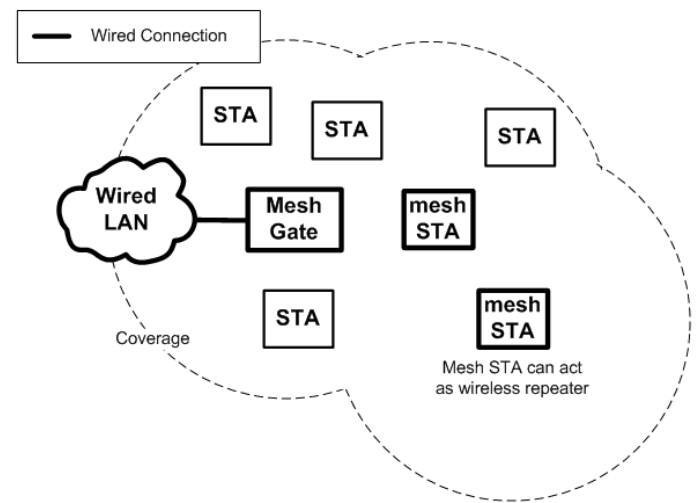
Figure 3. WLAN with a mesh